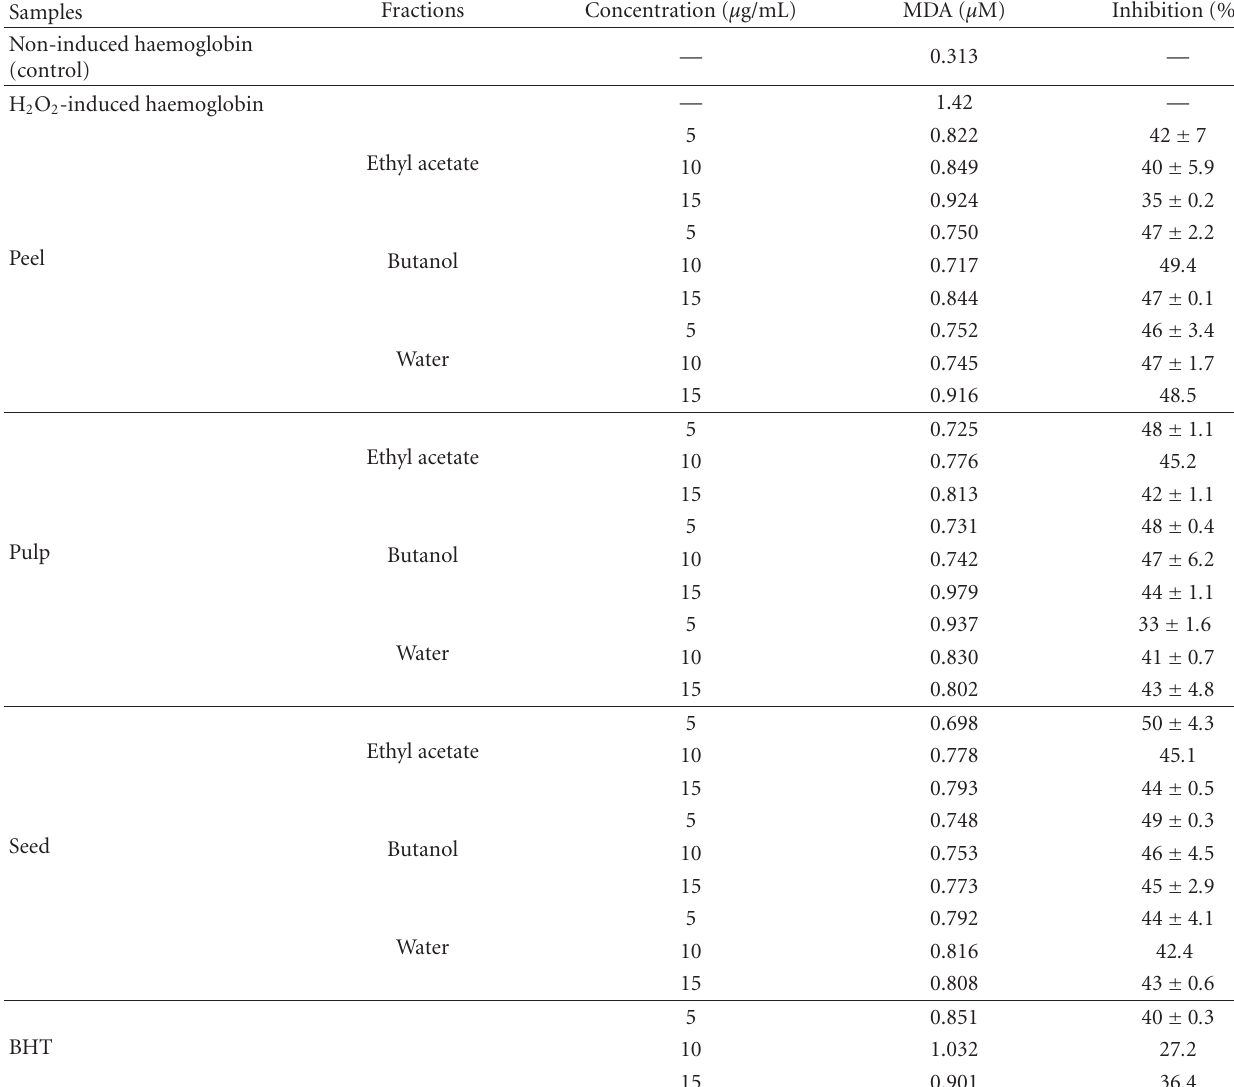
Table 2: Hemoglobin oxidation inhibitory activity of Canarium odontophyllum